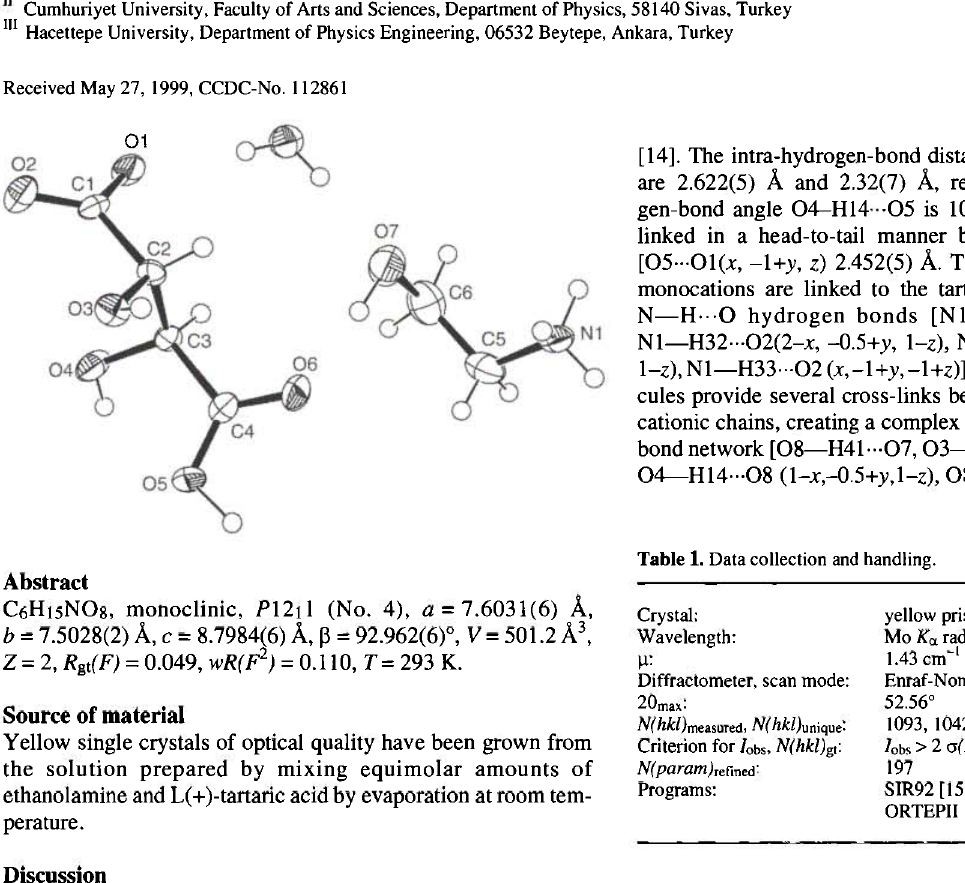
Table 1. Data collection and handling.